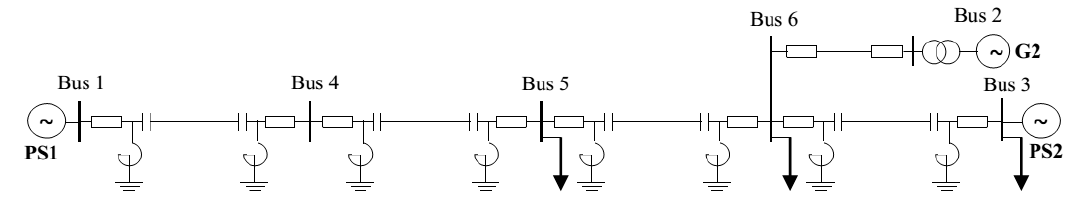
Figure 4. Six bus power system.